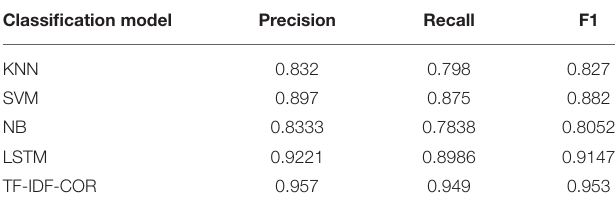
TABLE 1 | Performance comparison of different classification models.